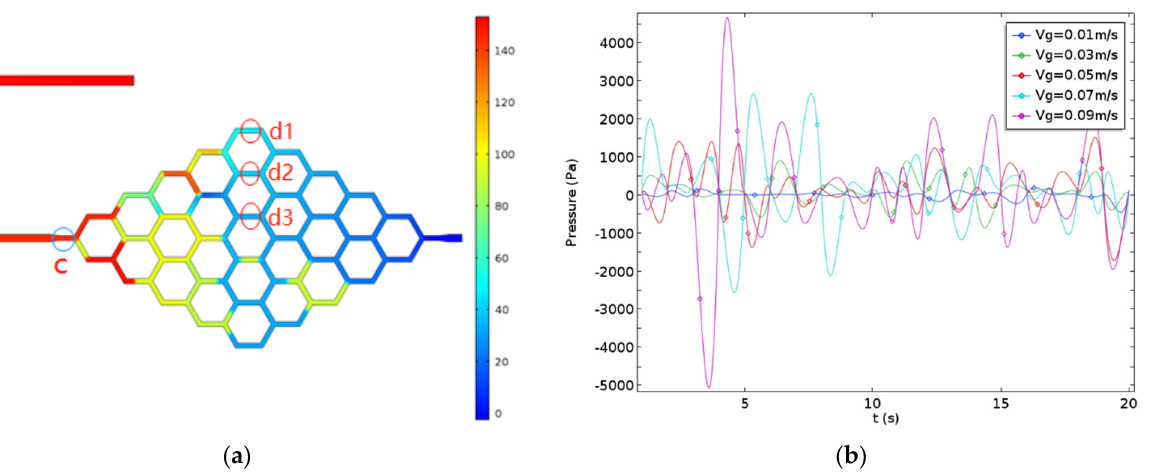
Figure 9. ( a ) Pressure distribution contour in the honeycomb microchannel, Pa; ( b ) Pressure fluctuation of point C with time under different working conditions.